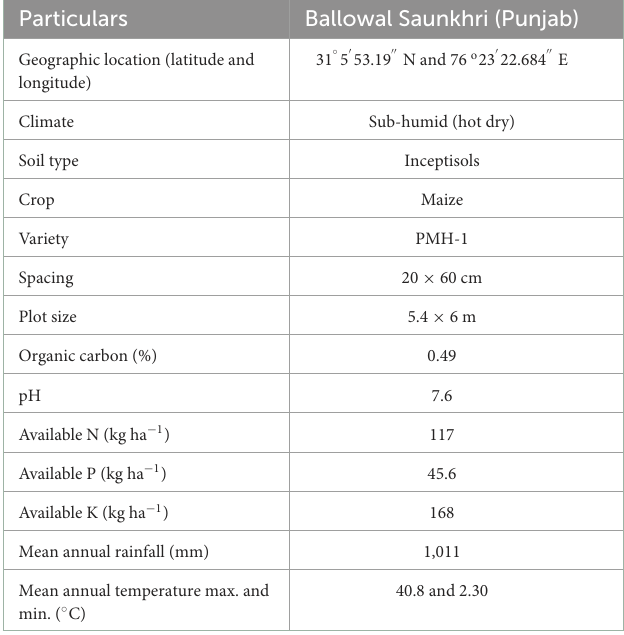
TABLE 1 Geographic, climatic, and edaphic properties of the experimental site.